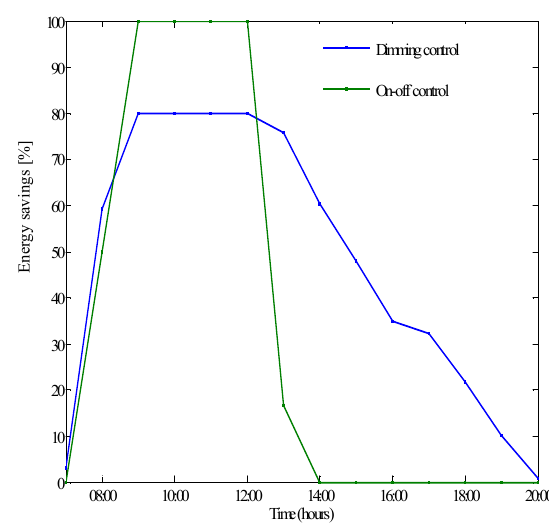
Figure 5. Energy savings with on/off and dimming